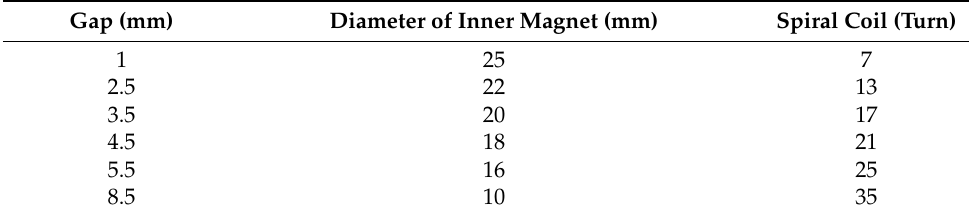
Table 1. The dimensions of magnets and the number turns of the coil. Gap (mm) Diameter of Inner Magnet